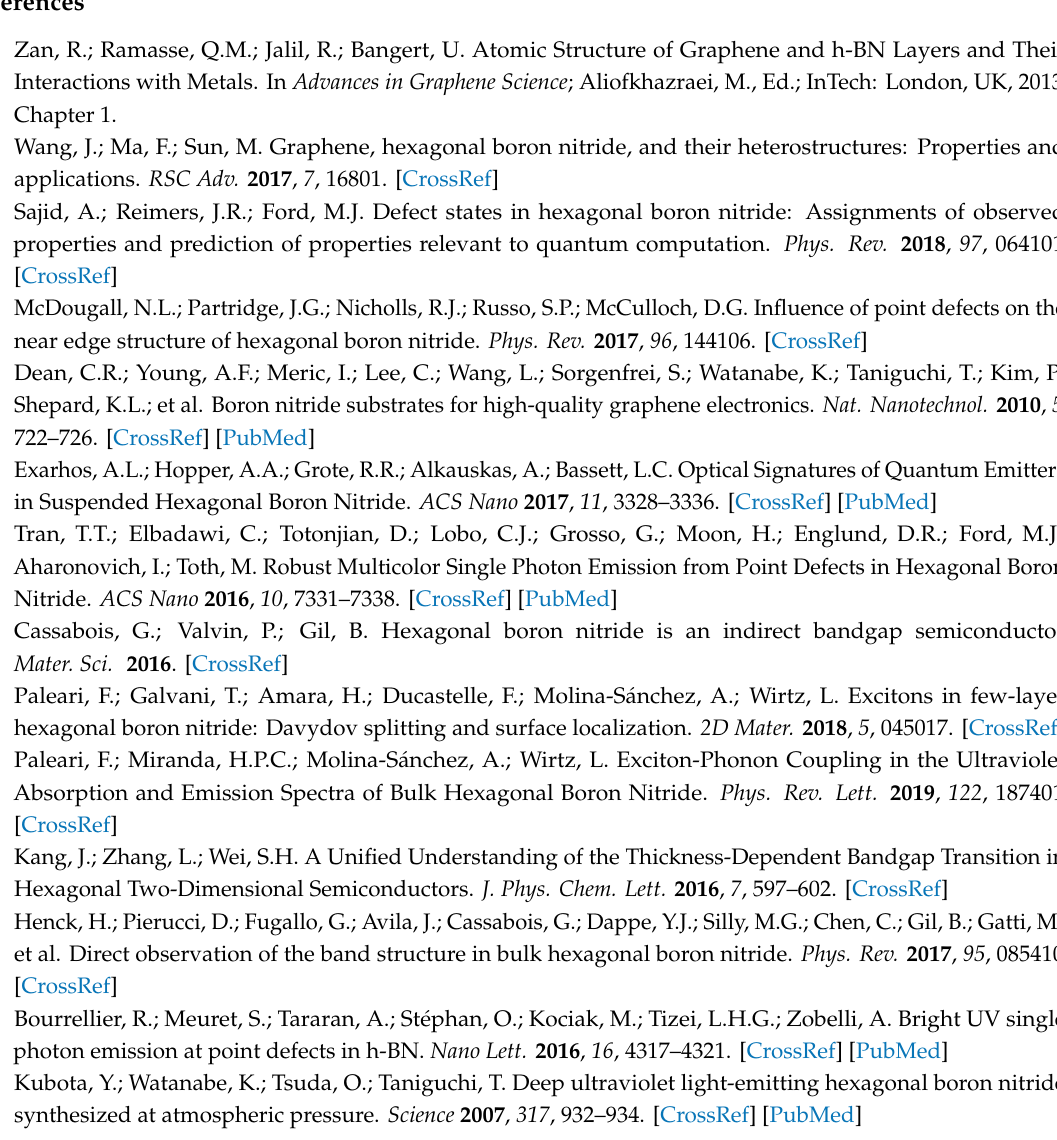
Figure S2: White illuminated optical image of a hBN flake and its decomposition to RGB channels. Figure S3: OC of R, G, B channels and band pass filters for SiO 2 thickness of 290 nm as function of number of hBN layers with shown experimental data extracted from optical images. Figure S4. AFM images of some of measured areas with hBN thickness ranging from 1 to 5